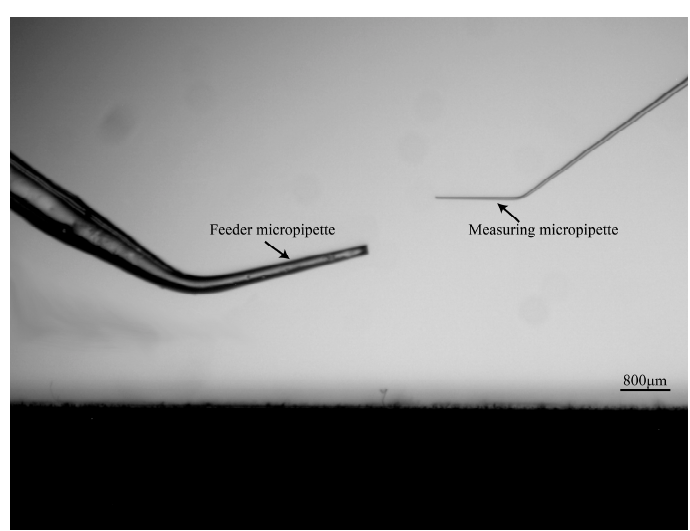
Figure 4. The FM was tilted to 12.3°, and the MM was horizontal.